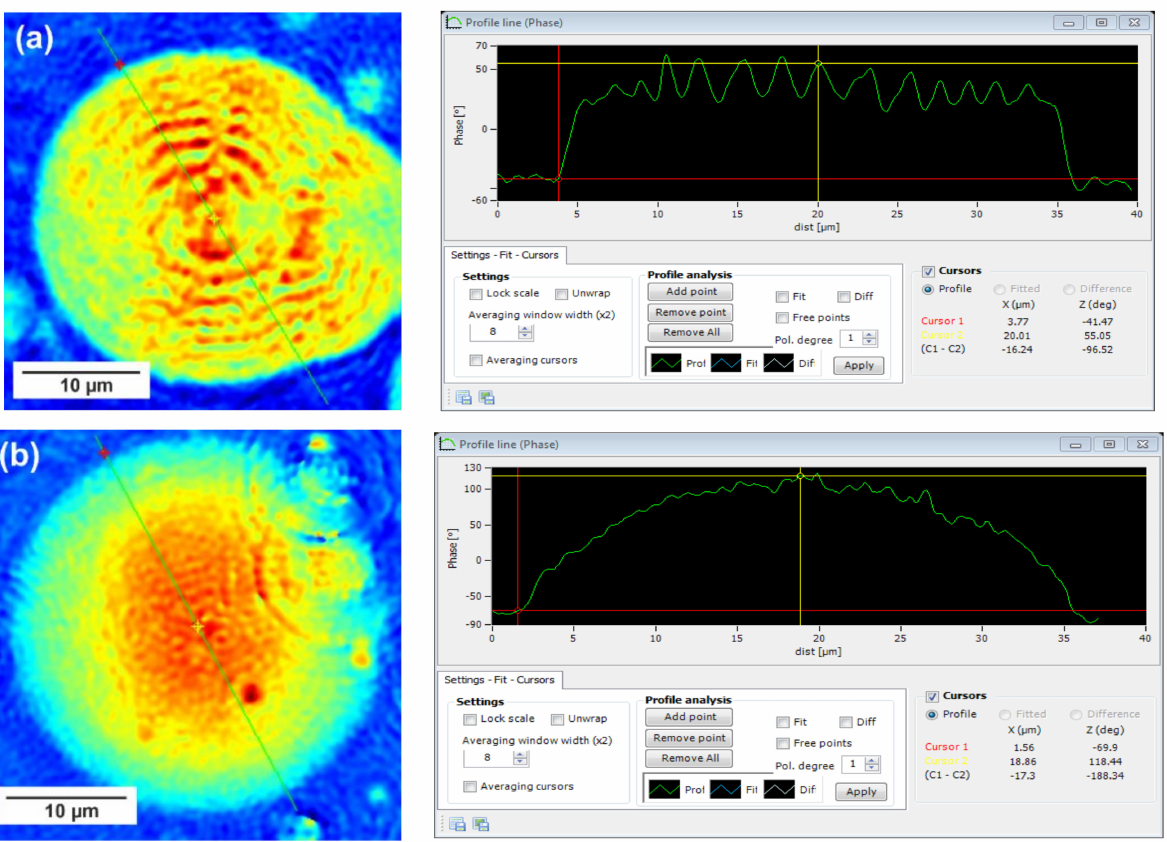
Figure 8. Holographic images and corresponding profiles of the phase changes along the green line recorded for a single spherulite crystalized from the melt for ( a ) PBS-DLS 90-10_E and ( b ) PBS-DLS 90-10_M. The DHM microscope magnification is 50 ×